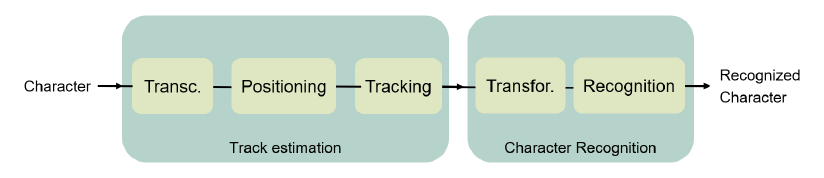
Figure 1. General block diagram for air-writing